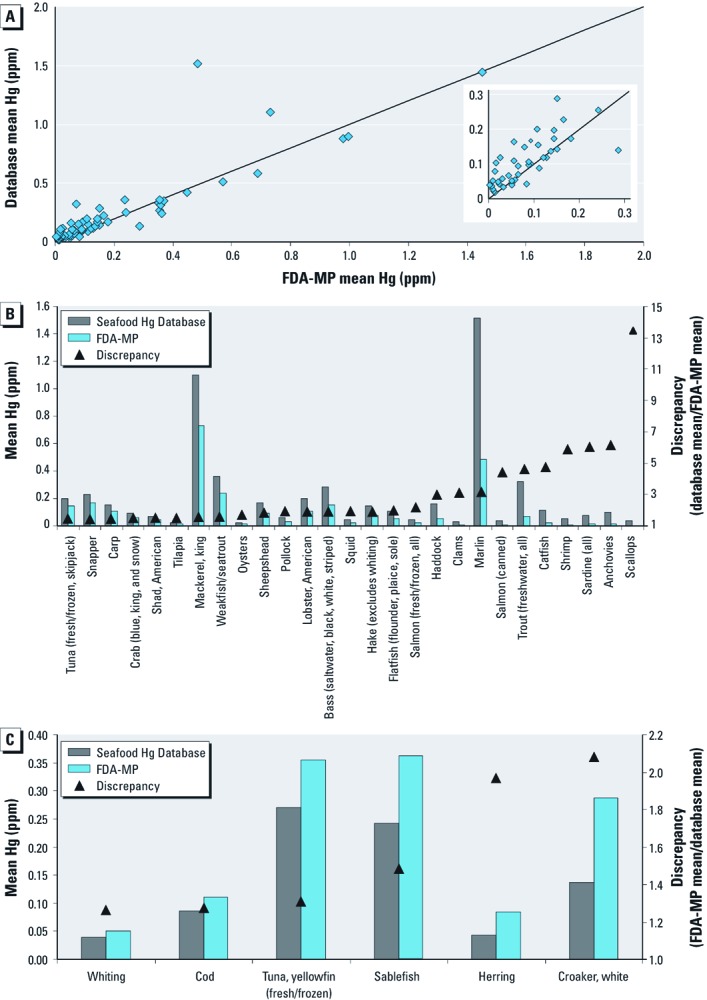
Comparison of Hg content estimated from the Seafood Hg Database (database) with data from the the FDA‑MP. (A) Mean Hg content for 58 seafood items relative to the 1:1 line. Inset, mean Hg content estimates for seafood items with mean Hg ≤ 0.3 ppm. (B) Seafood items for which FDA‑MP underestimates of mean Hg content are lower than mean estimates based on the Seafood Hg Database (discrepancy = Seafood Hg Database mean/FDA‑MP mean). (C) Seafood items for which FDA‑MP overestimates of mean Hg content are higher than the Seafood Hg Database (discrepancy = FDA‑MP mean/ Seafood Hg Database mean; the inverse of discrepancy in (B). Larger discrepancy values > 1 indicate larger difference. Seafood items for which discrepancy is < 20% were excluded.